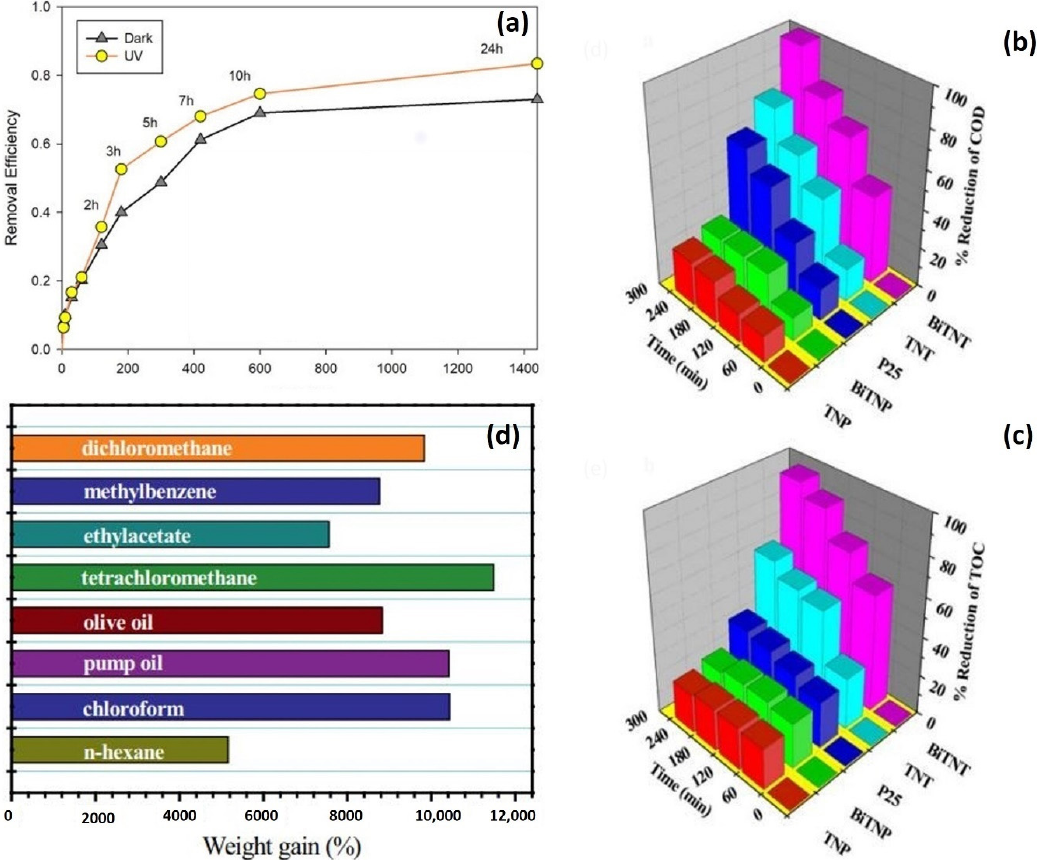
Figure 21. ( a ) The absorption rate of MO (25 mg/L) employing KP-ZnO-PANI in the dark and under UV light. The graphic shows the dye’s UV–Vis spectra at different time ranges. Reprinted with permission from Ref. [48]. Copyright 2018, copyright Elsevier; ( b ) Reduction in COD and ( c ) TOC values as a percentage. Reprinted with permission from Ref. [133]. Copyright 2013, copyright Springer Nature; ( d ) CKD/RGO aerogel adsorption capability towards various organic solvents and